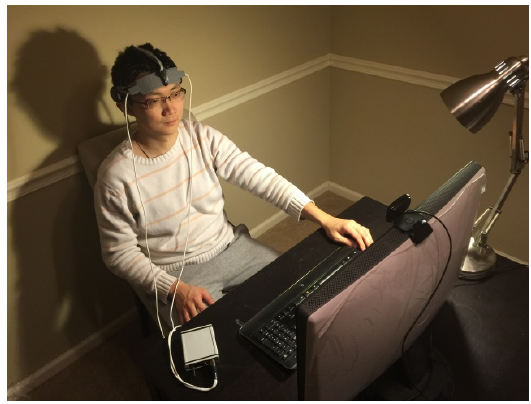
Figure 3. Experimental environment and participant wearing brain monitoring sensors.